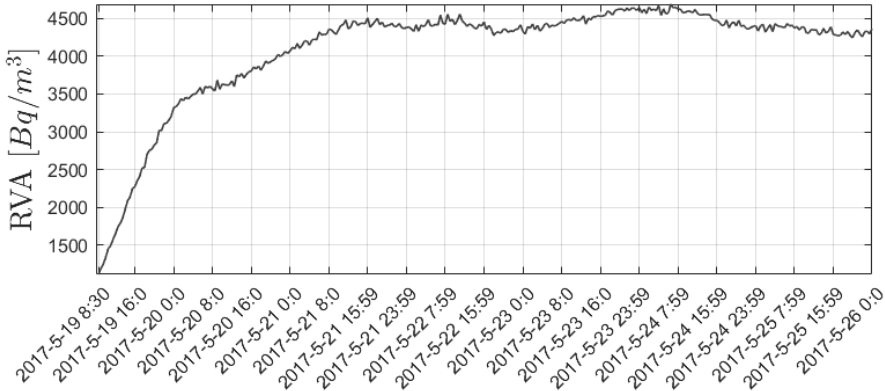
Figure 4. Observation data from the YSSR observation